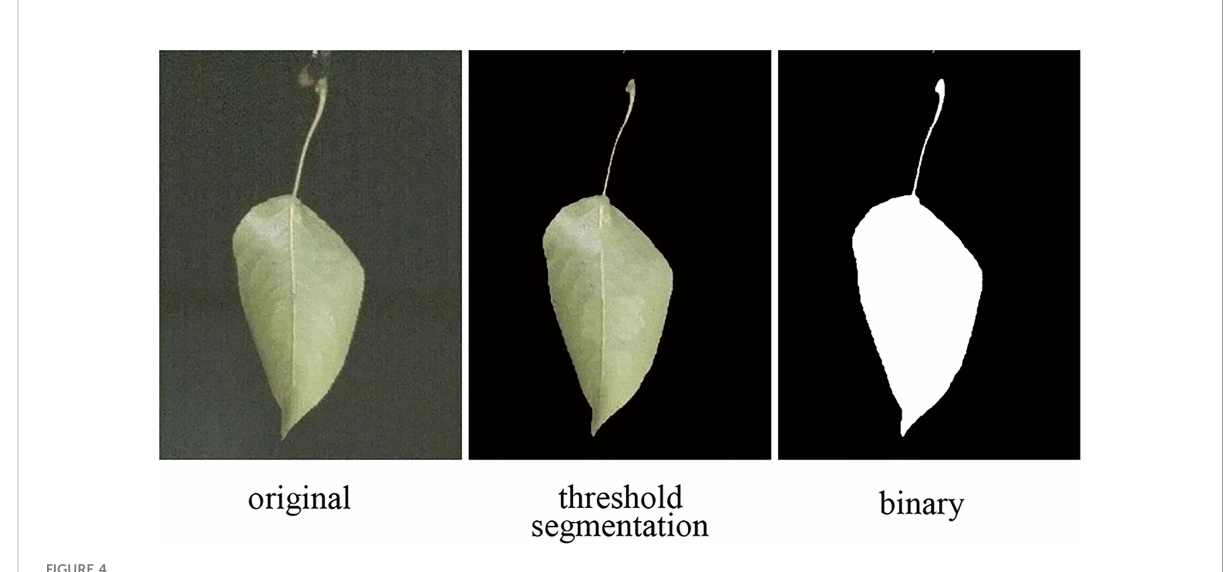
FIGURE 4 Image processing to obtain the wind de fl ection area of the